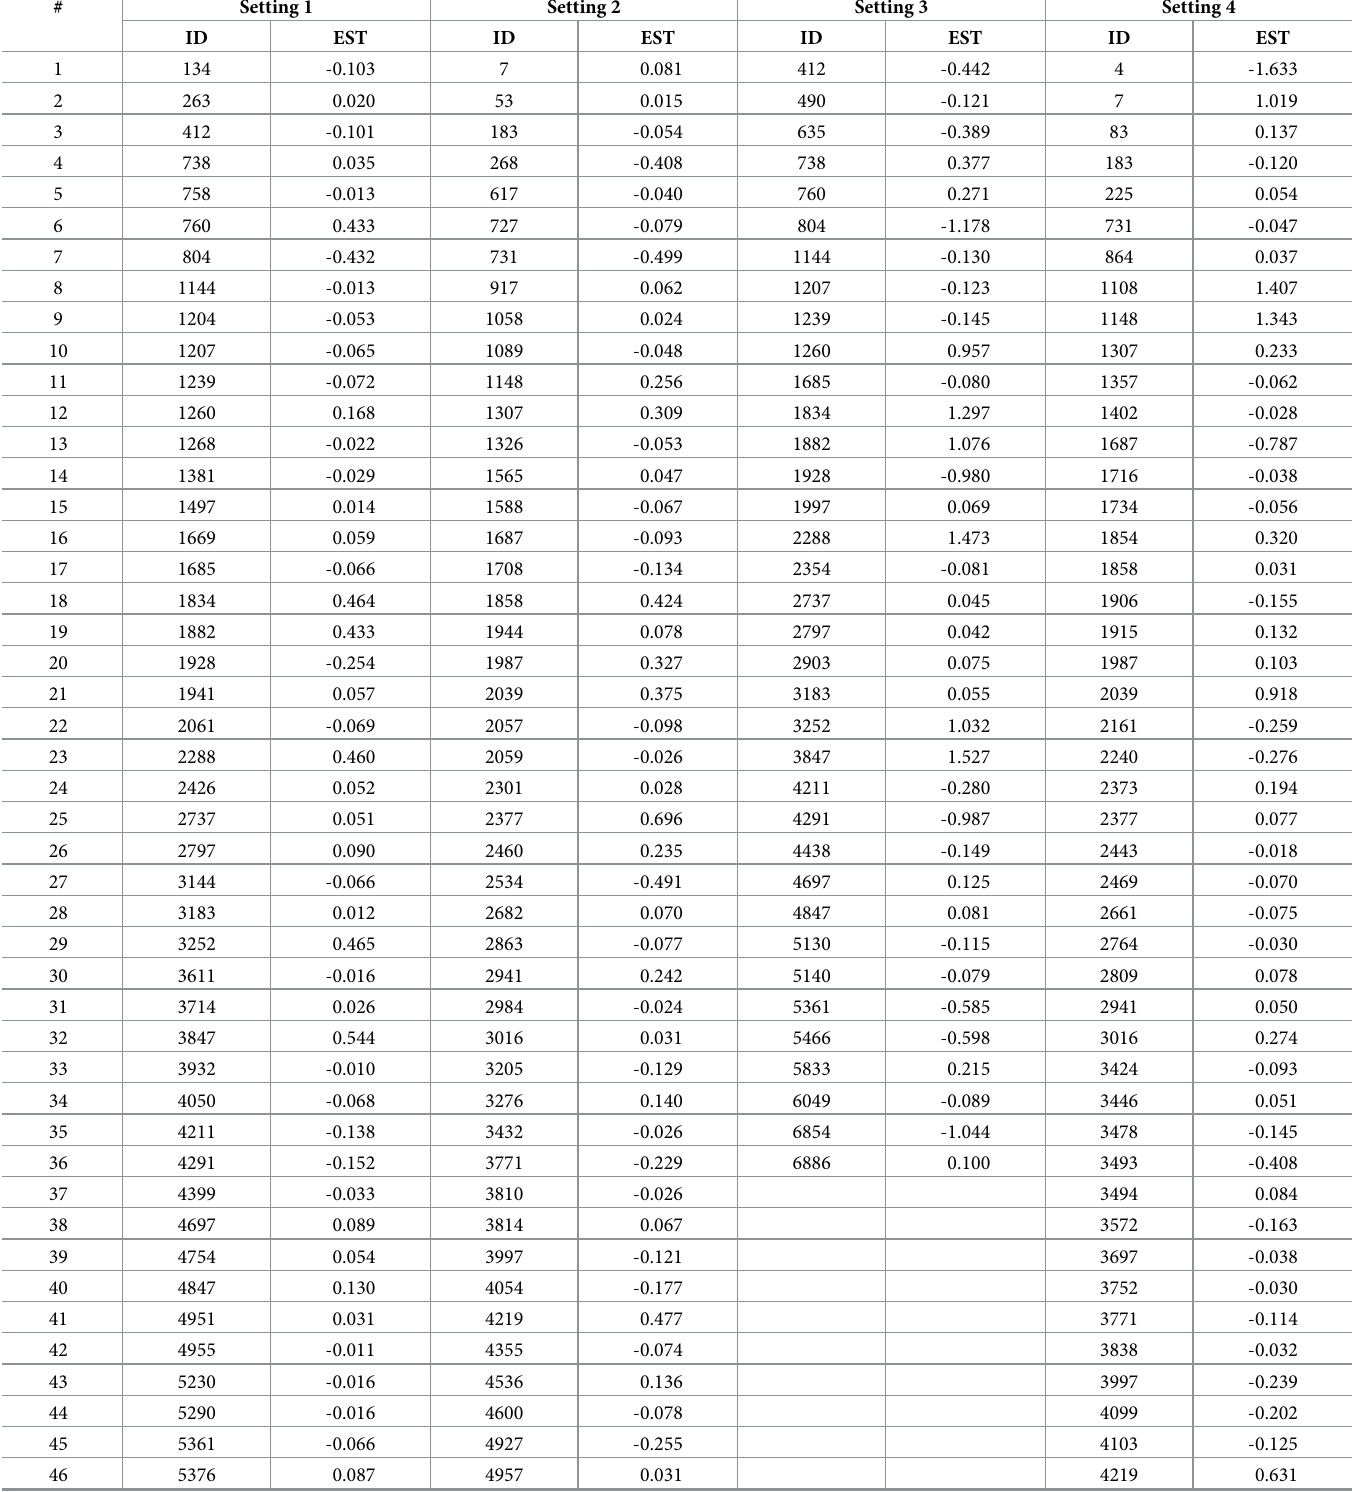
Table 2. Estimation results based on the probit